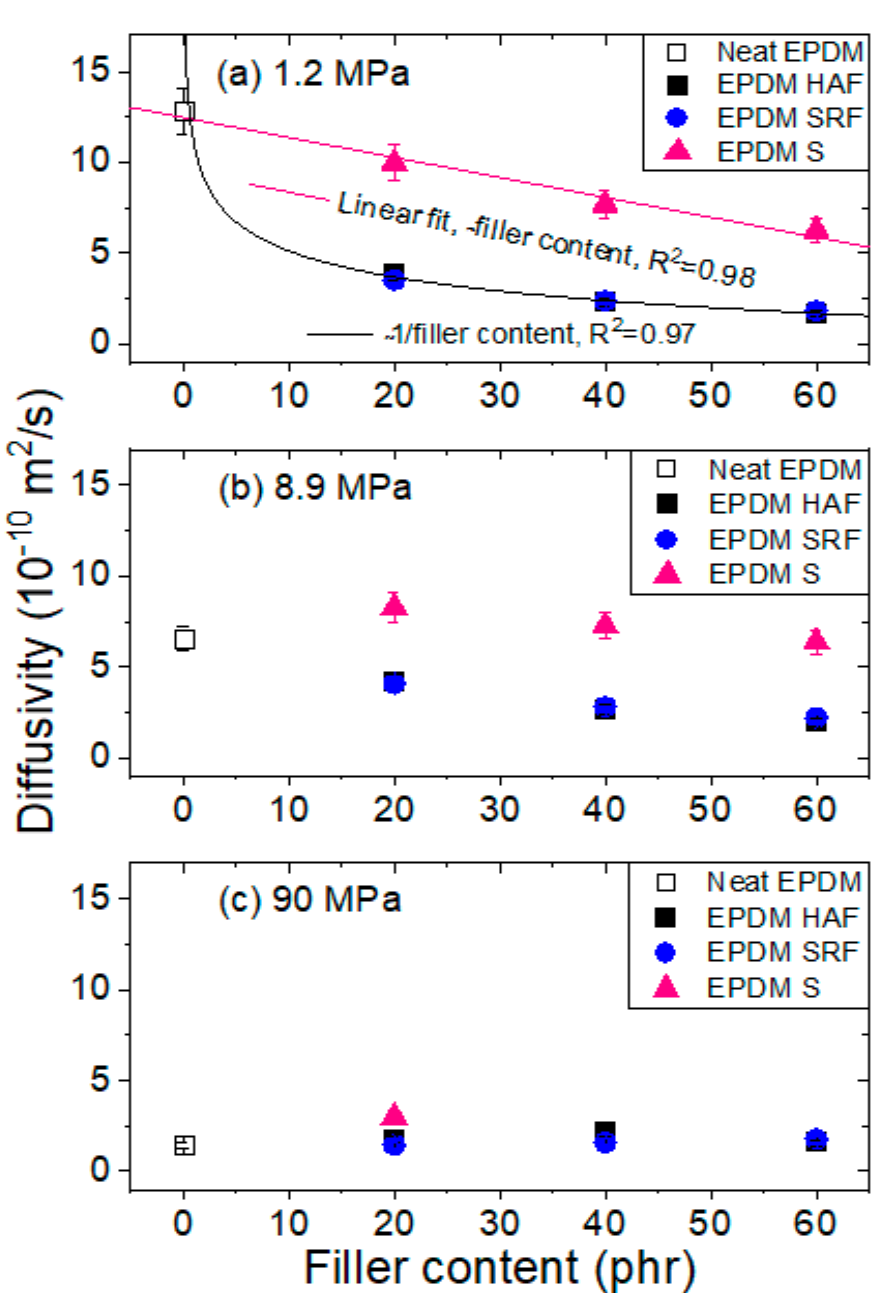
Figure 8. Diffusivity versus filler content at exposure to pressure of ( a ) 1.2 MPa, ( b ) 8.9 MPa, and ( c ) 90 MPa in EPDM composites blended with CB and silica. The pink line in ( a ) is fitted with a negative linear relationship between the diffusivity and the filler content. The black line in ( a ) is fitted with a linear relationship between the diffusivity and the reciprocal filler content. R 2 is squared correlation coefficients of